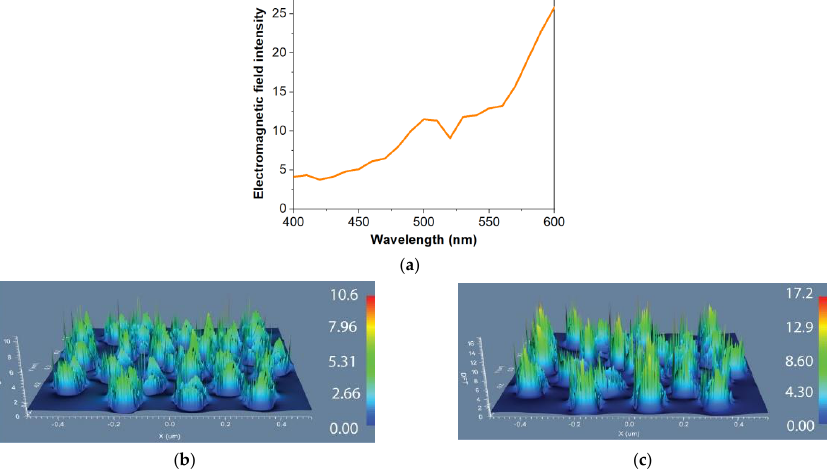
Figure 3. ( a ) Electromagnetic fields average enhancement as a function of wavelength: ( b ) Field configurations for a silver random metasurface at the wavelength of 480 nm; ( c ) Field configurations for a silver random metasurface at the wavelength of 550 nm.